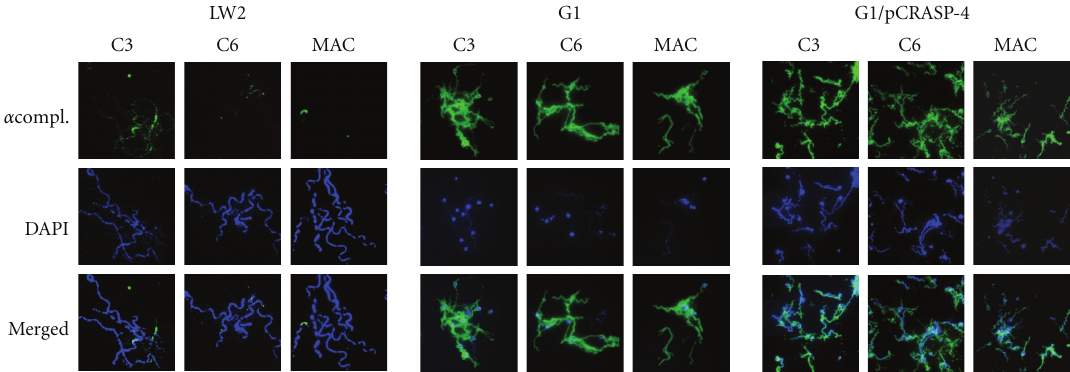
Figure 6: Deposition of complement components C3 and C6, and MAC on the surface of borrelial strains. Deposition of complement components on B. burgdorferi LW2 (control strain), B. garinii G1 and transformant G1/pCRASP-4 were detected by indirect immuno- fluorescence microscopy. Spirochetes were incubated with 25% NHS. Bound C3, C6, or MAC was detected using specific antibodies against each component plus appropriate Alexa-488-conjugated secondary antibodies. For visualization of intact spirochetes, the DNA-binding dye DAPI was used. Slides were visualized at a magnification of × 1,000 and the data were recorded via a DS-5Mc CCD camera (Nikon) mounted on an Olympus CX40 fluorescence microscope. Panels shown are representative of at least 20 microscope